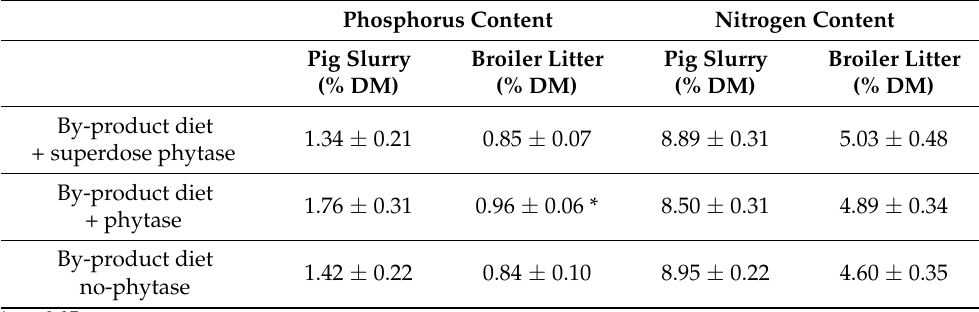
Table 1. Total phosphorus and nitrogen content (%) of pig slurry and broiler litter produced by animals under different diets characterised by varying phytase levels. ‘no-phytase’, ‘phytase’ (com- mercial levels at 250 FTU or 500 FTU Quantum ® Blue, for pigs and broilers, respectively), and ‘superdose phytase’ (1000 FTU or 1500 FTU Quantum ® Blue, for pigs and broilers, respectively). No significant differences were detected among %P and %N content across the different diets except for P% content of broiler litter, which was higher under the ‘Phytase’